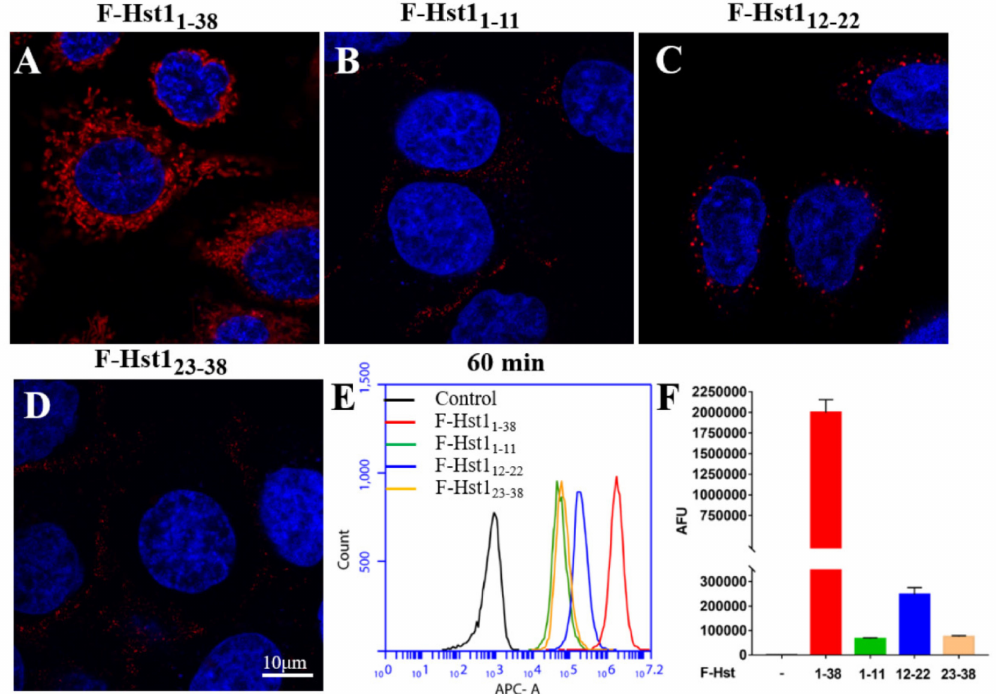
Figure 7. Cellular uptake of the F-Hst1 and truncated variants, such as F-Hst1 1-11 , F-Hst1 12-22 and F-Hst1 23-38 by HO1N1 epithelial cells. ( A – D ) CLSM images showed that a significantly higher amount of F-Hst1 accumulated in the vicinity of nuclei than F-Hst1 12-22 , while F-Hst1 1-11 and F-Hst1 23-38 showed only mild accumulation. ( E , F ) Flow cytometric analysis confirmed that F-Hst1 showed the highest cell-associated fluorescence density, which was followed by F-Hst1 12-22 . In contrast, F-Hst1 1-11 and F-Hst1 23-38 showed only mild fluorescence density. Data were presented as mean ±